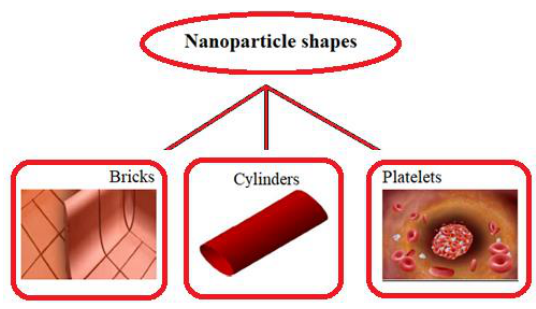
Figure 2. Different nanoparticle shapes. Table 2. Shape factors and coefficients of the nanoparticles